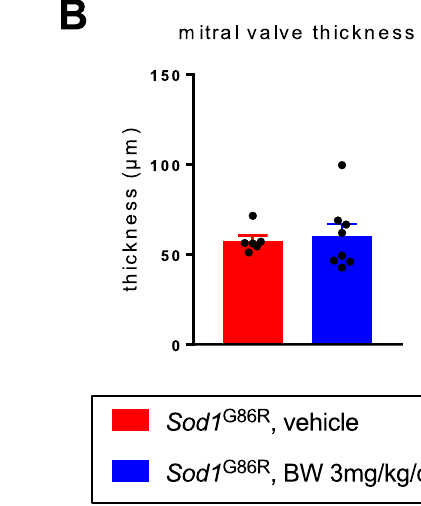
Fig. 5A. Iba1 + cells were classified in 4 different activation states (resting, activated, phagocytic or dystrophic). No statistically significant difference in microglial morphology between groups was found regarding the pro- portion of each cell phenotypes (Fig. 5B). Importantly, BW treatment (3 mg/kg/d) did not modify the loss of motor neurons observed in Sod1 G86R mice as judged from counting ChAT positive cells in the ventral spinal cord (Fig. 5C). Thus, BW modifies microglia associated gene expression but does not appear to modify microglial morphological alterations or motor neuron degeneration in Sod1 G86R mice.